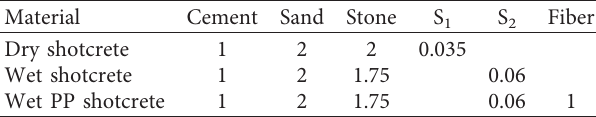
Table 1: Mix proportions of shotcrete (mass ratio).